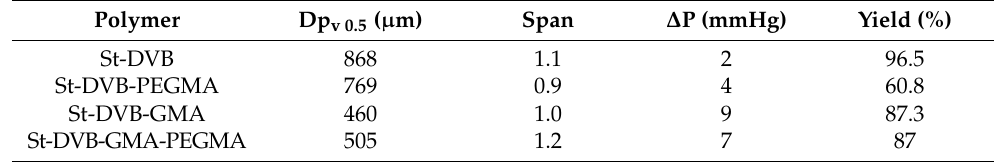
Table 2. Median diameter in volume, Span, estimated pressure drops and